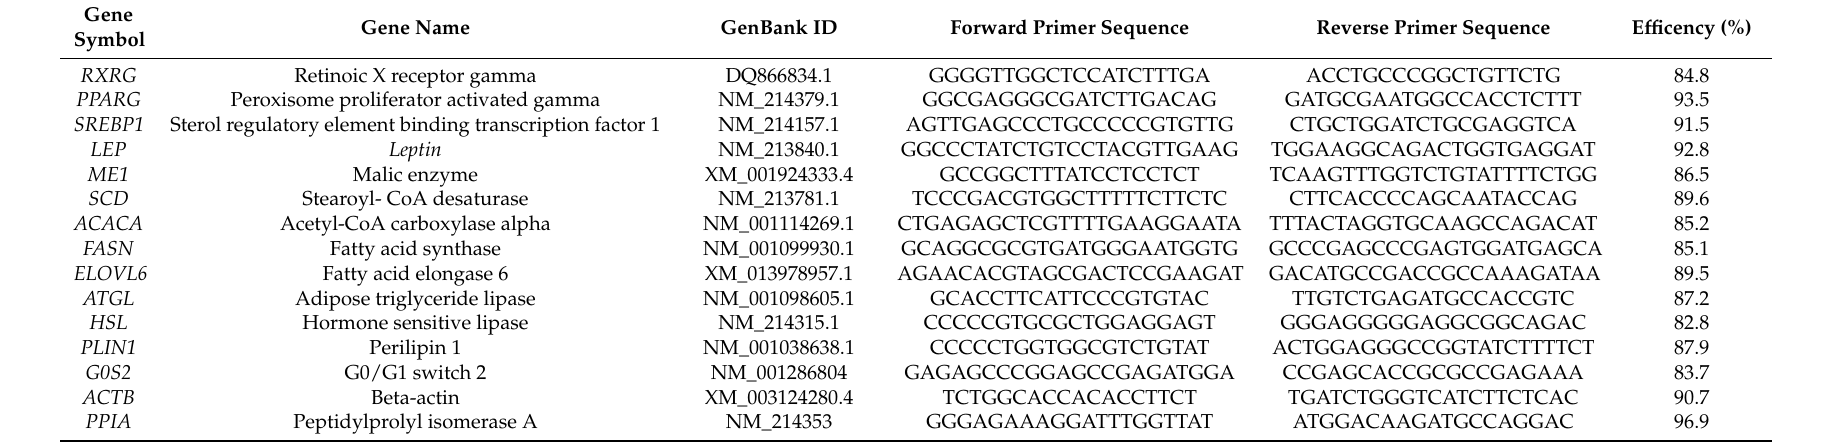
Table 6. Primer design for qPCR and PCR